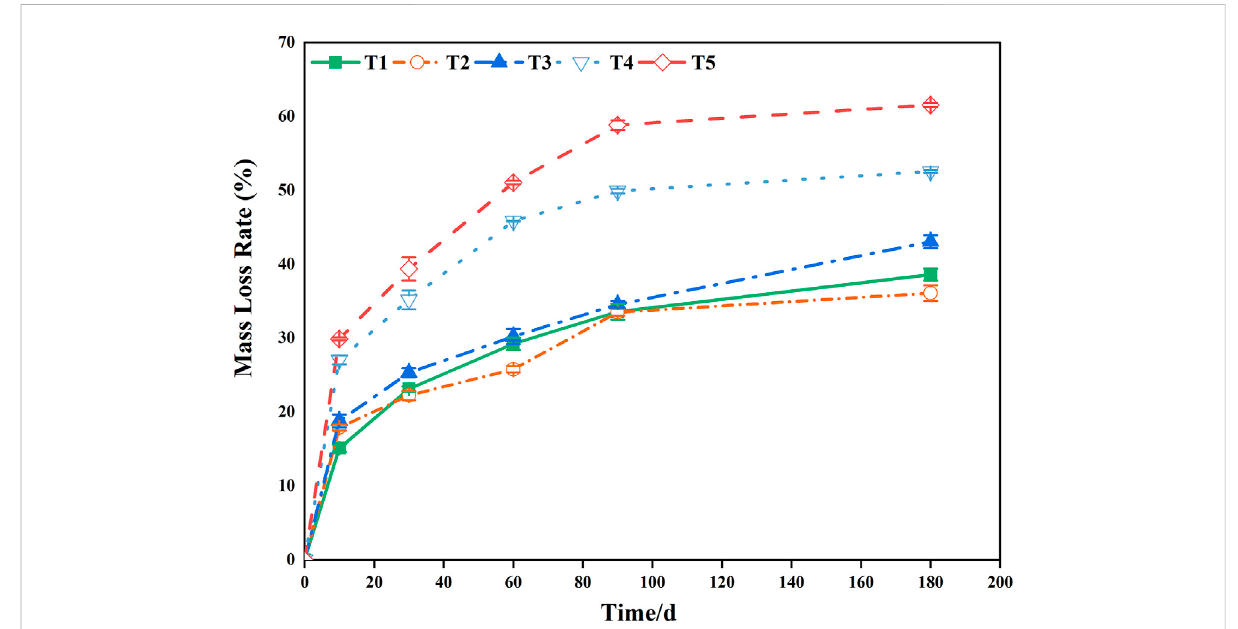
FIGURE 1 Changes intherateof foliarmasslossduring decompositionintheThreeGorges Reservoir,China. T1represents conventional water treatment [control check (CK)], T2represents mild droughtstress, T3represents saturated water content, T4represents light fl ooding stress,and T5represents severe water fl ooding stress.